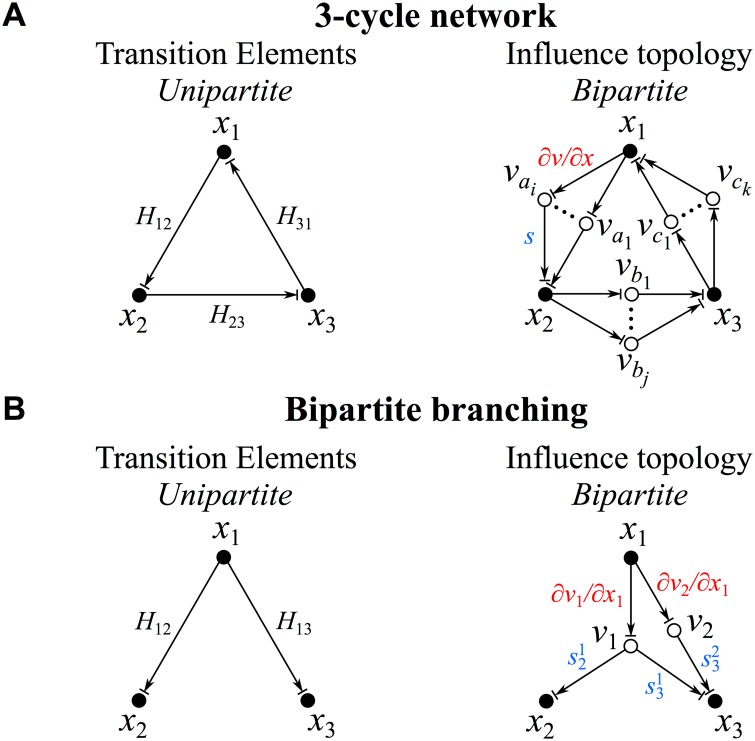
Unipartite versus bipartite representations.(A) Unipartite graph of a network comprised of a single 3-cycle; edges are labeled with the corresponding transition matrix elements of unspecified sign (left). The bipartite representation (influence topology) of this network is also displayed (right); here, species-to-reaction node edges correspond to the Jacobian elements (∂v/∂x) and reaction-to-species node edges correspond to the stoichiometries (s). (B) Unipartite versus bipartite depiction of a branching influence of one species on two immediately downstream species. See §2 for further details.